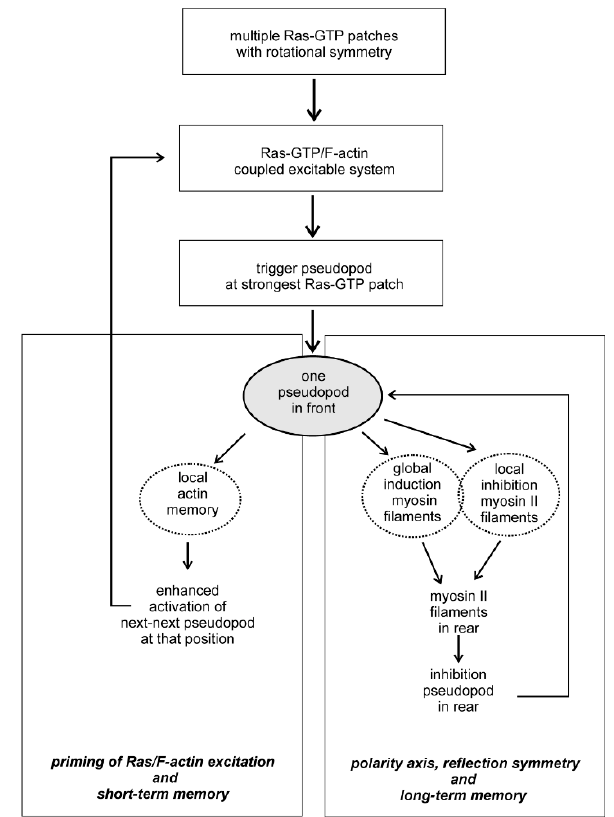
Figure 3. Flow diagram of symmetry, excitability and memory for cell movement.